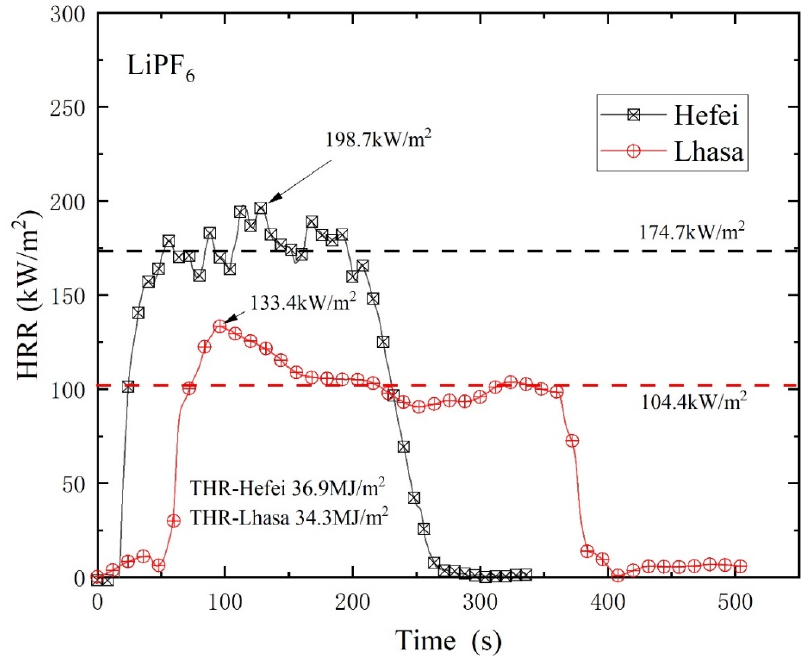
Figure 11. HRR curves of electrolyte with LiPF 6 in Hefei (black) and Lhasa (red).